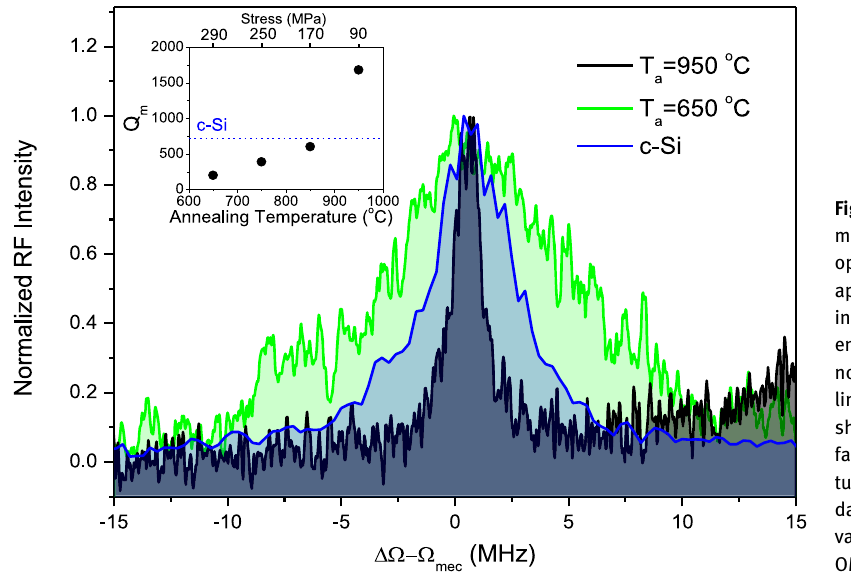
Figure 3: Normalized RF spectra of a mechanical breathing mode